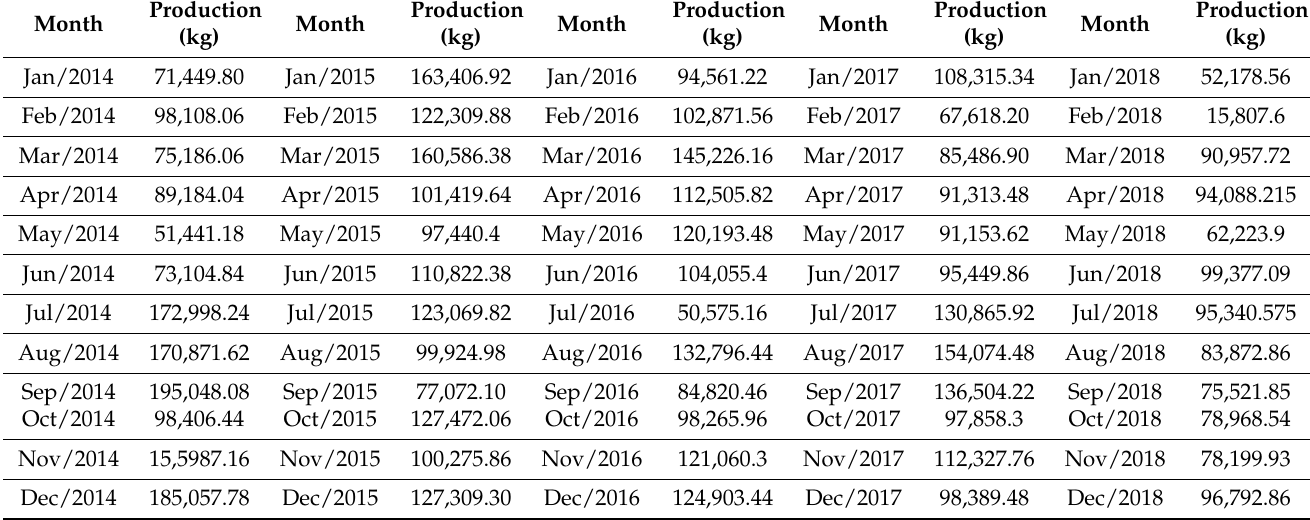
Table A3. Potato production